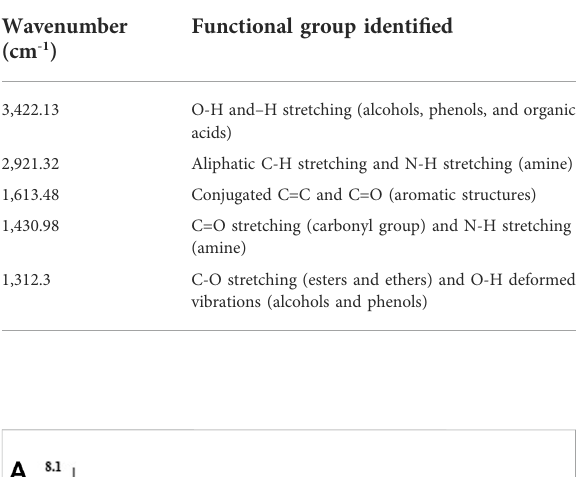
TABLE 4 Surface functional groups of Cannabis sativa